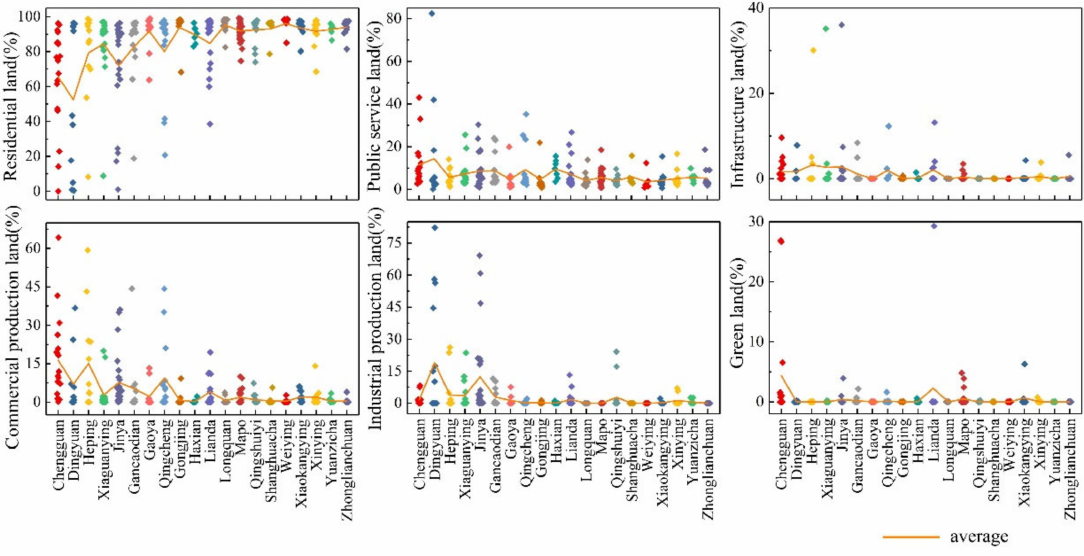
Figure 2. The proportion of various types of rural construction